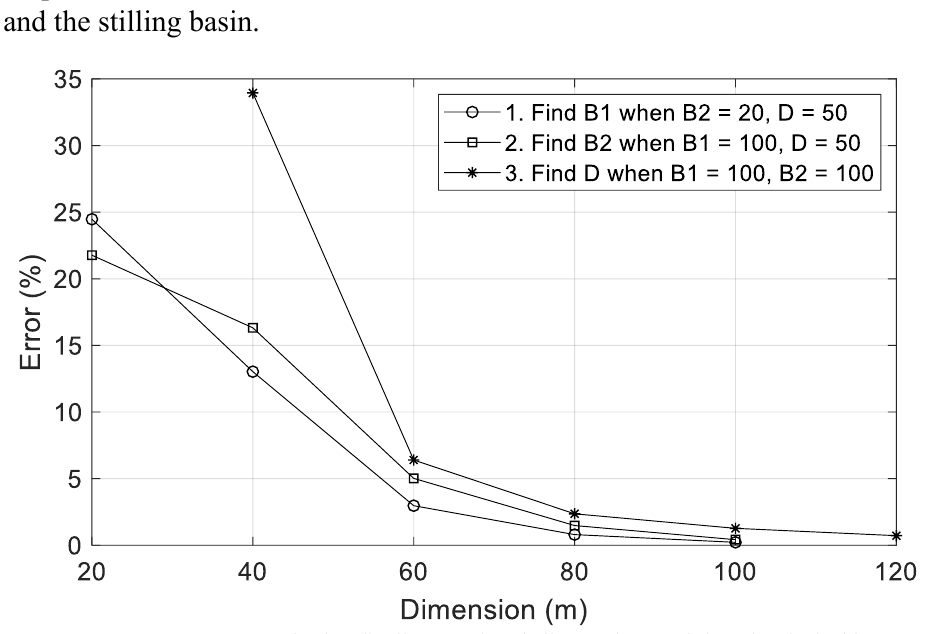
Fig. 6. Convergence study for finding optimal dimensions of the elastic half